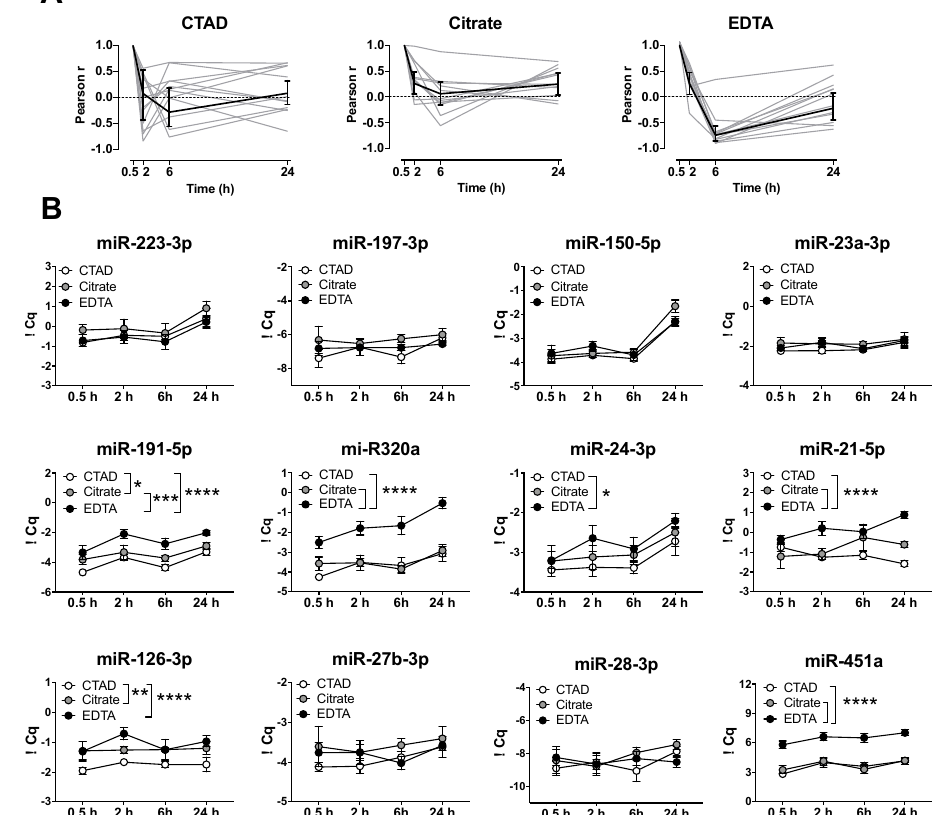
Figure 3. Time-dependent differences in circulating miRNA levels. ( A ) Pearson correlation coefficients between timepoint 0.5 h and all other timepoints for all miRNAs after storage at 4 °C. Each thin grey line represents one of 12 miRNAs; the bold lines represent means; error bars are 95% confidence intervals. Pearson correlation coefficient (r) of +1 indicates that the respective time point gives the same result as the 0.5 h time point; values of 0 would indicate that the values of that time point were unrelated to the values obtained at 0.5 h, and negative values indicate inverse values. ( B ) Blood from 6 healthy donors was prevented from coagulating with CTAD (white), citrate (gray), or EDTA (black) and stored at 4 °C for 0.5 (immediate plasma preparation), 2, 6, or 24 h until plasma preparation. Data are represented as means with standard errors. Significant differences were determined by two-way ANOVA using Sidak’s multiple comparison test and are depicted as * p < 0.05, ** p < 0.01, *** p < 0.001, and **** p <